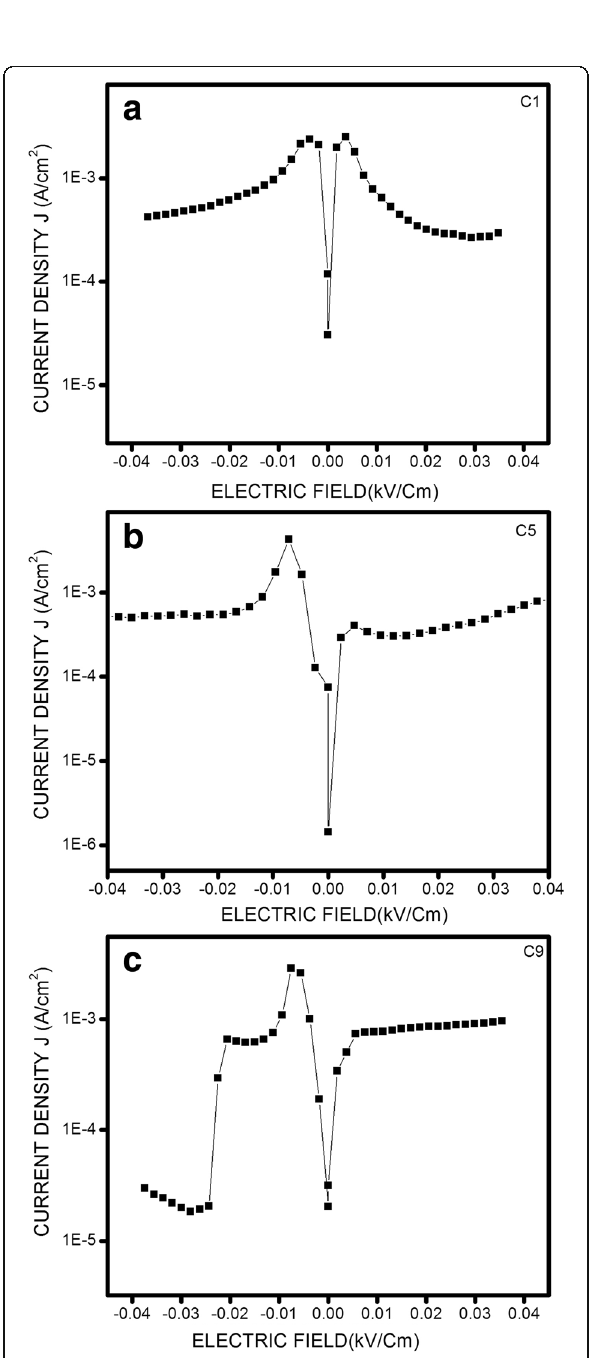
Fig. 10 Leakage current density of coated particle as a function of electric field of a Co 0.1 Mn 0.45 Zn 0.45 Fe 2 O 4 , b Co 0.5 Mn 0.25 Zn 0.25 Fe 2 O 4 , and c Co 0.9 Mn 0.05 Zn 0.05 Fe 2 O